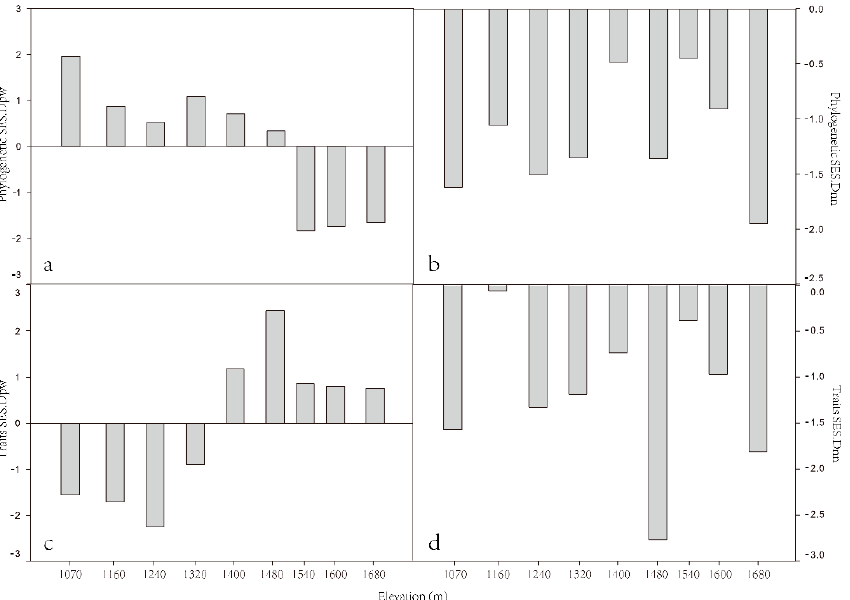
Figure 2. Phylogenetic and functional trait beta diversity along an elevational gradient: ( a ) phylogenetic SES.Dpw, ( b ) phylogenetic SES.Dnn, ( c ) trait SES.Dpw, and ( d ) trait SES.Dnn.